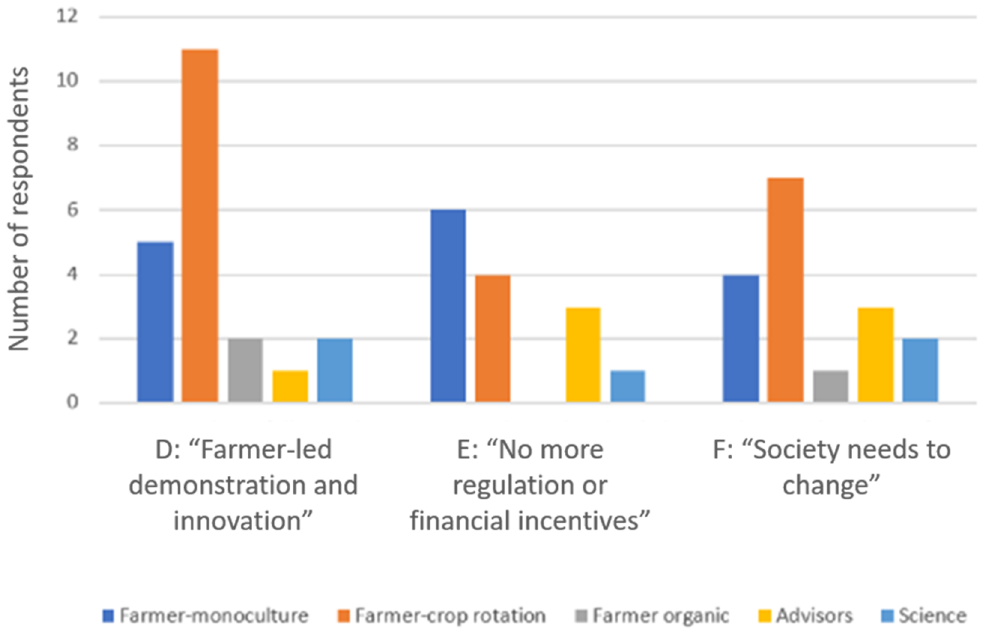
Figure 4. Professions of Norwegian respondents loading onto the three solution factor groups.